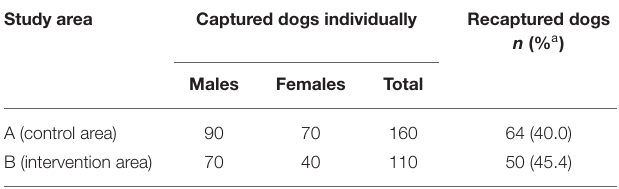
TABLE 1 | Number of free-roaming dogs captured/recaptured during seven sampling efforts performed between 2012 and 2014 in Divinópolis, Minas Gerais, Brazil.